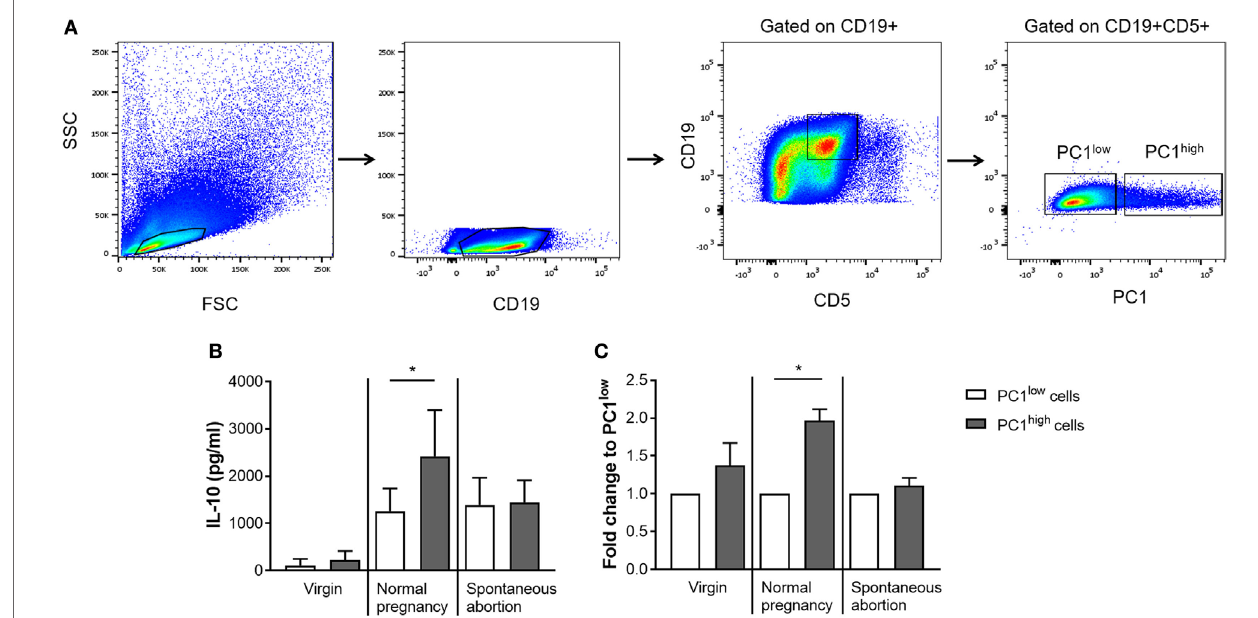
FigUre 3 | Peritoneal PC1 high cells from normal pregnant (NP) females secreted significantly more IL-10 than their PC1 low counterparts obtained from the same animals. Peritoneal CD19 + CD5 + B1a B cells were sorted from virgin ( n = 2), NP ( n = 6), and abortion-prone ( n = 3) females based on the height of their PC1 expression and subdivided in PC1 low and PC1 high cells. The sorting strategy is displayed in panel (a) . Sorted cells were cultured for 24 h in medium containing lipopolysaccharide and phorbol 12-myristate 13-acetate. Afterward, the levels of IL-10 secreted by either PC1 low or PC1 high cells were determined (B,c) . Data are displayed as means + SEM. Analysis was performed by using the Wilcoxon matched-pairs signed rank test (* p ≤ 0.05).